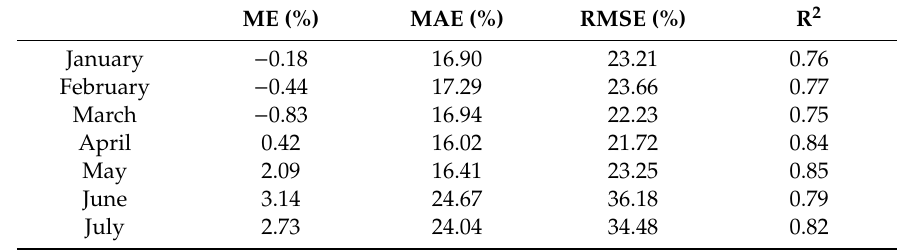
Figure 12. Scatter plots of estimated versus observed seasonal and annual precipitation totals. Table 2. Mean statistics for the precipitation estimates derived with the MISH mapping method vs. observed values following the application of LOOCV.